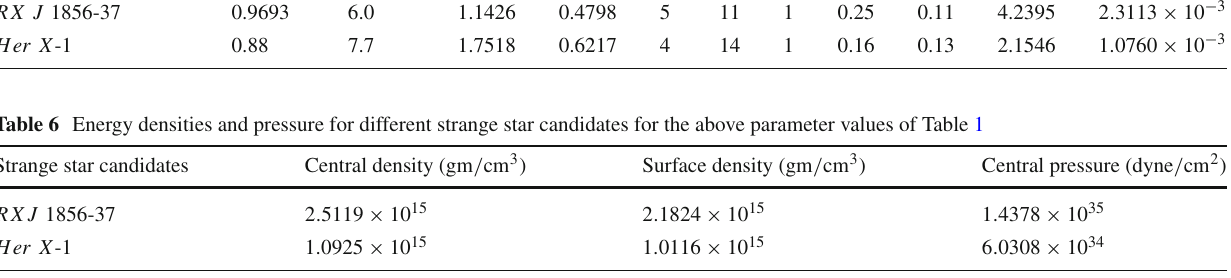
Table 5 Values of the model parameters A , B , m etc. for different strange stars Strange star candidates